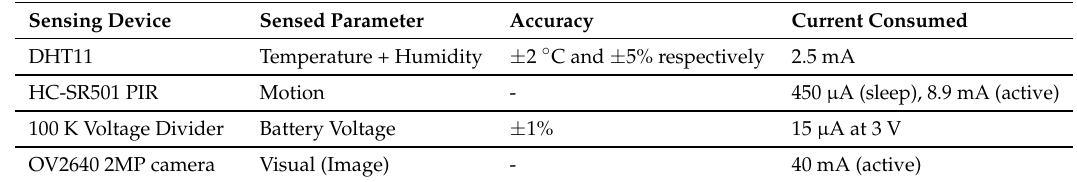
Table 3. Sensors used in the Ratspy